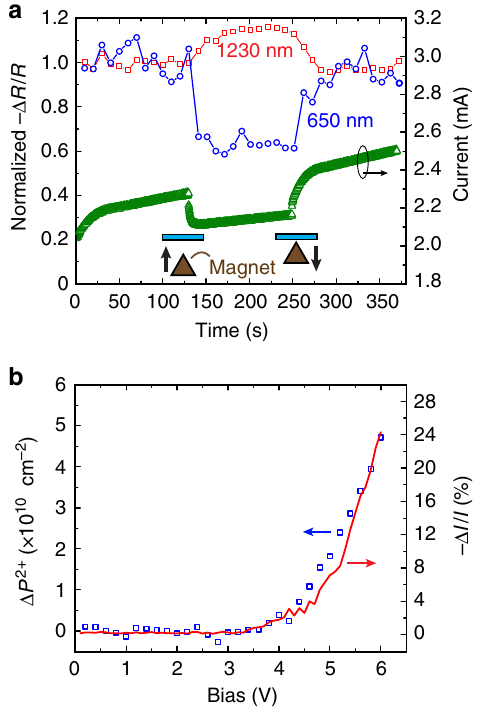
Fig. 2 Magnetic fi eld response. a Magnetic fi eld response of the polaron and bipolaron CM absorption bands recorded at λ = 1230 nm and λ = 650 nm, respectively, from a 200 nm thick TPD device operated at 5 V forward bias. The magnetic fi eld is applied during the indicated time interval by moving the apex of a fl ux-concentrated pyramidal permanent magnet adjacent to the device cathode as illustrated in the inset. The right-hand axis shows the associated decrease in current that occurs upon application of the magnetic fi eld, which is estimated to be > 0.5 T. b Bias dependence of the interfacial bipolaron concentration (blue squares) calculated from optical modeling of the charge modulation spectra. The right-hand axis shows that the magnetocurrent response of the device grows in direct proportion to the bipolaron